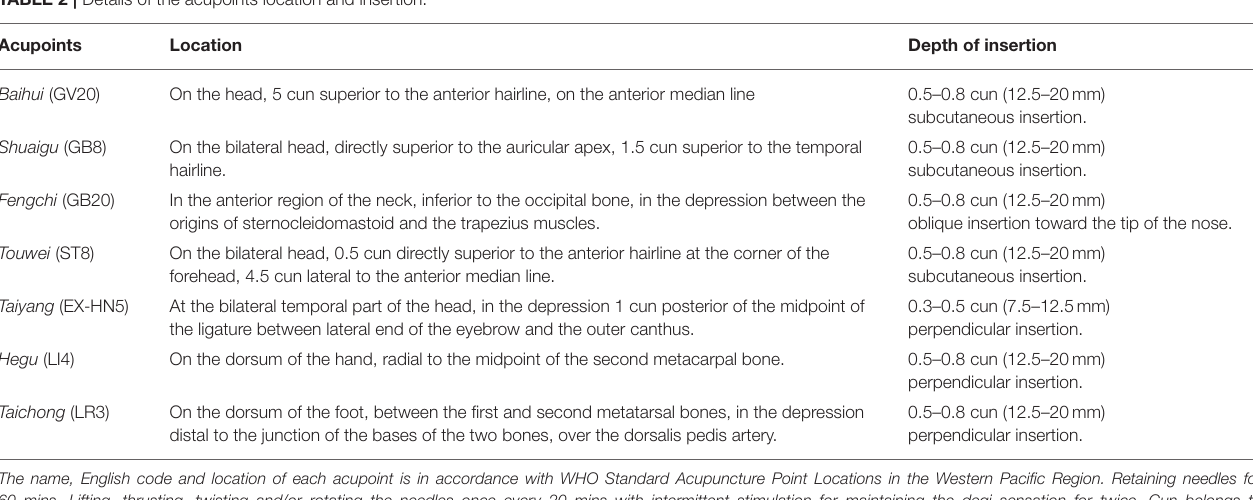
TABLE 2 | Details of the acupoints location and insertion.